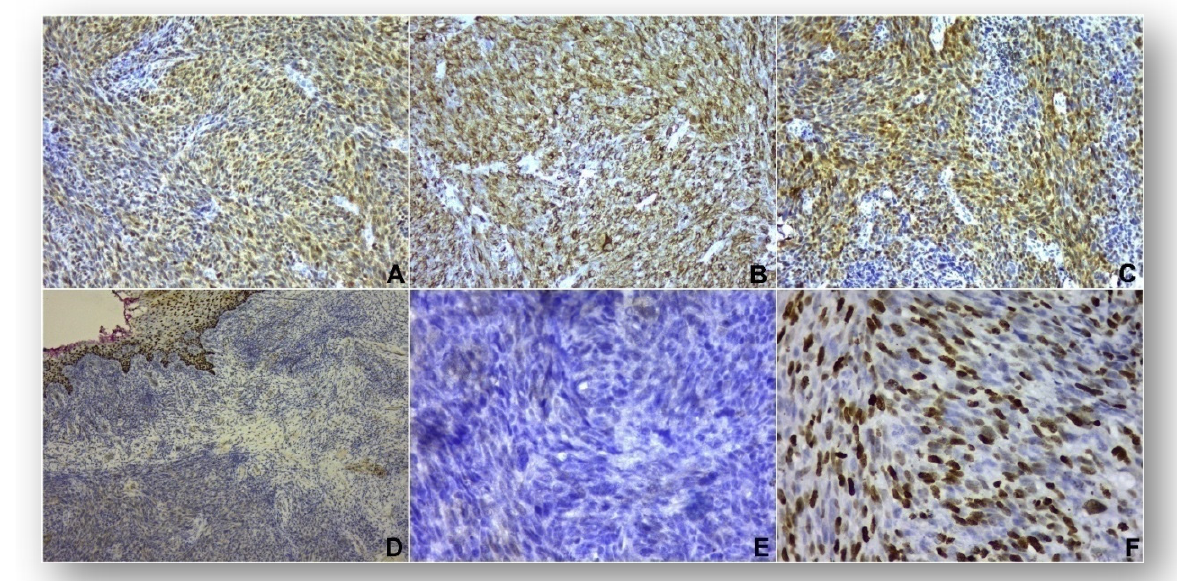
Figure 2. Immunohistochemical profile of the tumor: ( A ) Tumor cells are diffusely positive for S100, magnification × 200; ( B ) The tumor shows intense, diffuse positivity for HMB45, magnification × 200; ( C ) p16 is positive with moderate intensity, magnification × 200; ( D ) p63 is negative in the tumor cell and positive in the squamous epithelium (left upper quadrant), magnification × 100; ( E ) Tumor cells show negativity for CK5/6, magnification × 400; ( F ) A Ki-67 labeling index of 60%, magnification ×400.